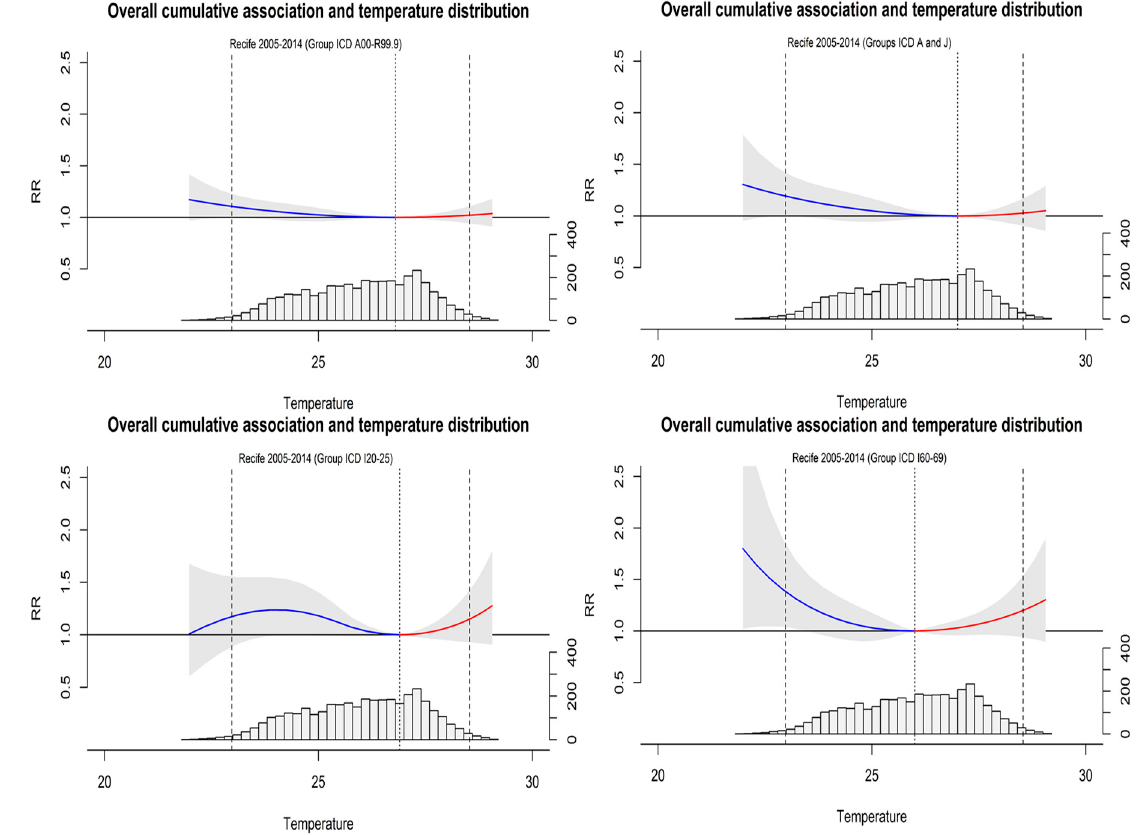
Figure 4. Grouped results for exposure-response curves for daily deaths by non-accidental mortality (ICD-10: A00-R99), groups ICD-10 diseases of the circulatory system and respiratory system (ICD-10: Groups I and J), diseases of cerebrovascular (I60-69), diseases of cardiovascular (I20-25), and histograms with the air temperature distribution for the health region of Recife between the years 2005 to 2014. The red line represents values below the MMT and the blue line represents values above the MMT.